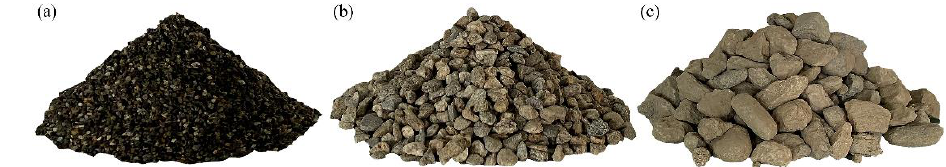
Figure 3. Sediments used in the experimental runs: ( a ) d 50 = 1.53 mm; ( b ) d 50 = 6.49 mm; ( c ) d 50 = 17.98 mm.